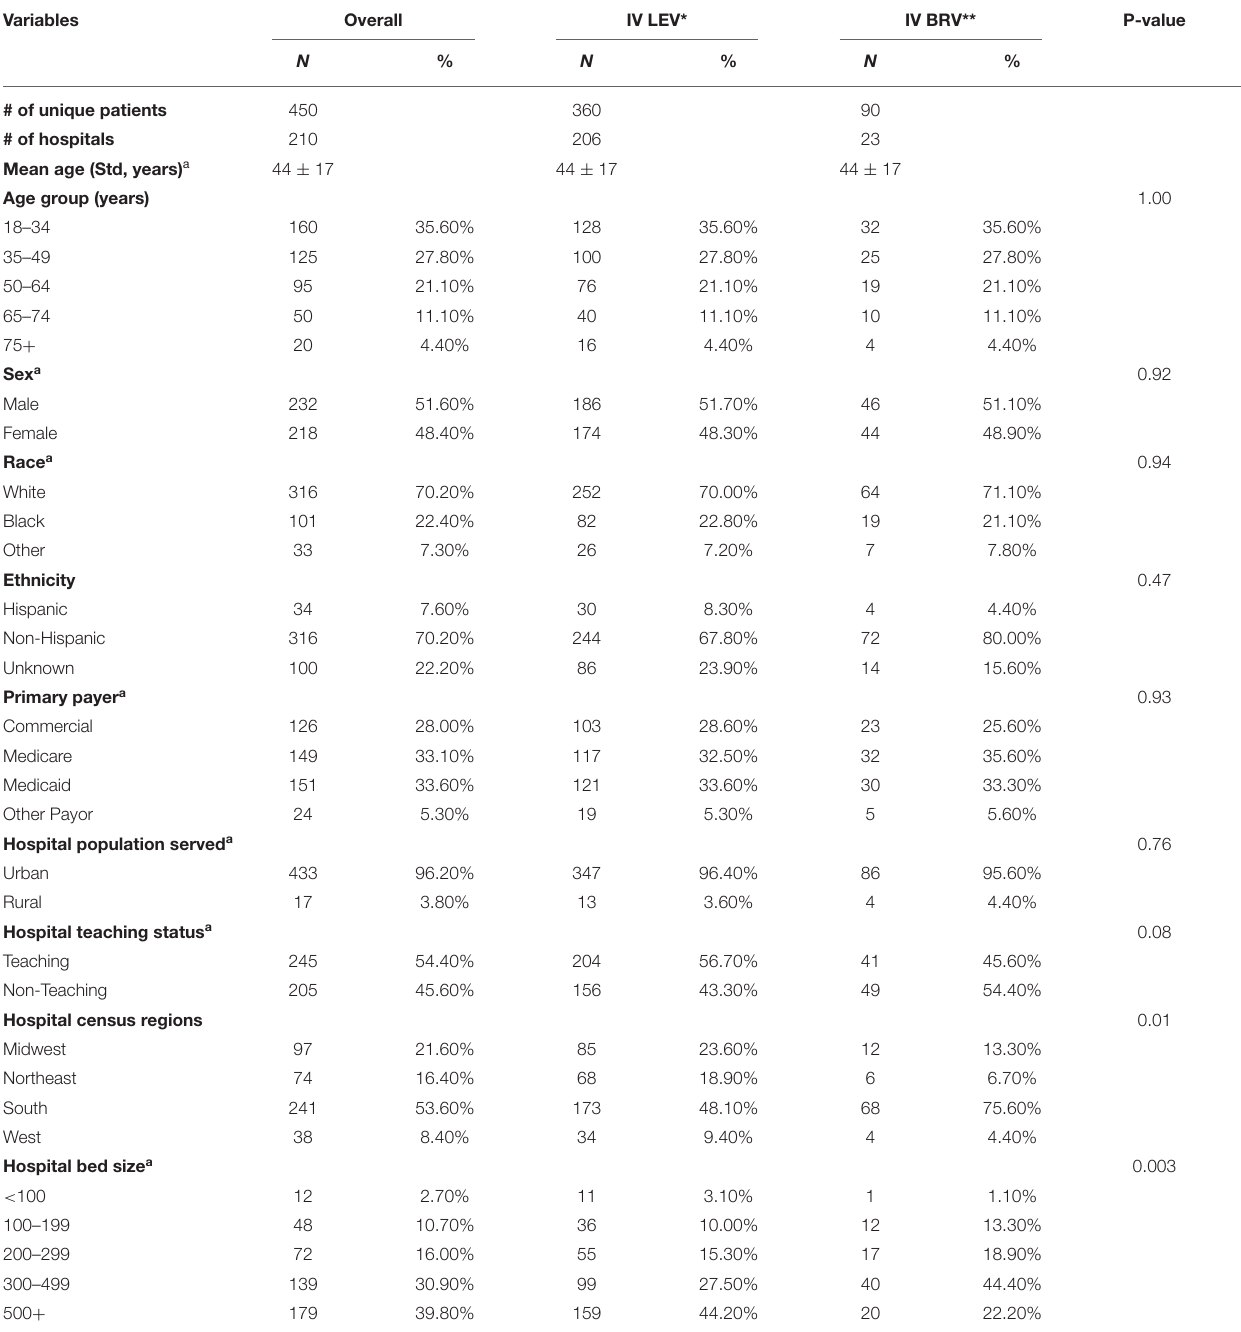
TABLE 1 | Patient demographic and hospital characteristics by treatment